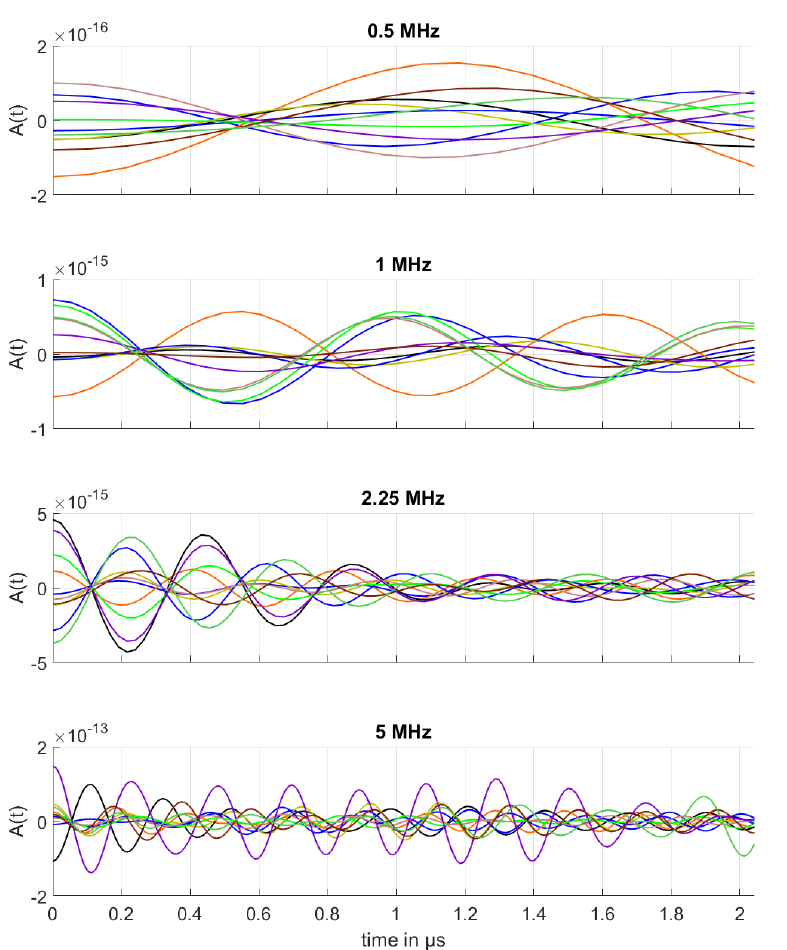
Figure 14. Backscattered signals (indicated by ten arbitrary colors) for a sequence of testing frequen- cies f = 0.5, 1, 2.25, and 5MHz. The corresponding transducer is modeled by a circle with radius 3 mm, which emits and receives longitudinal waves.